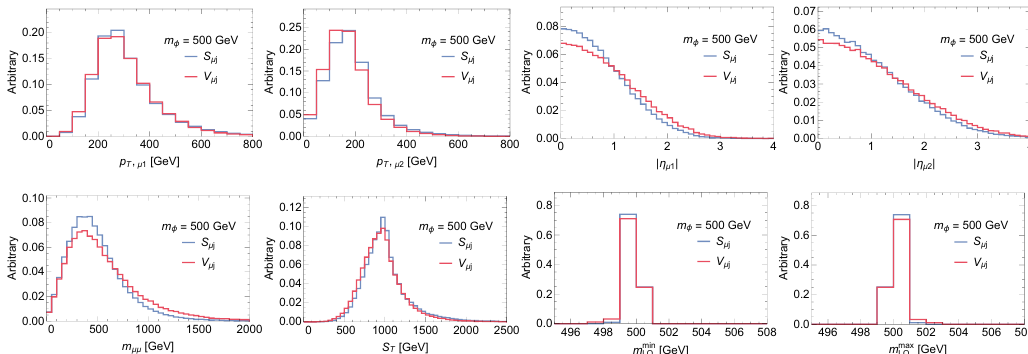
Figure 17 . Shape variables for scalar and vector leptoquarks with masses m passing the trigger cuts from ATLAS. Reconstructed leptoquark masses are arti(cid:12)cially narrow because our parton level analysis does not include detector resolution. Resolution e(cid:11)ects would also slightly smoothen the other plots and make vector and scalar distributions even more similar.